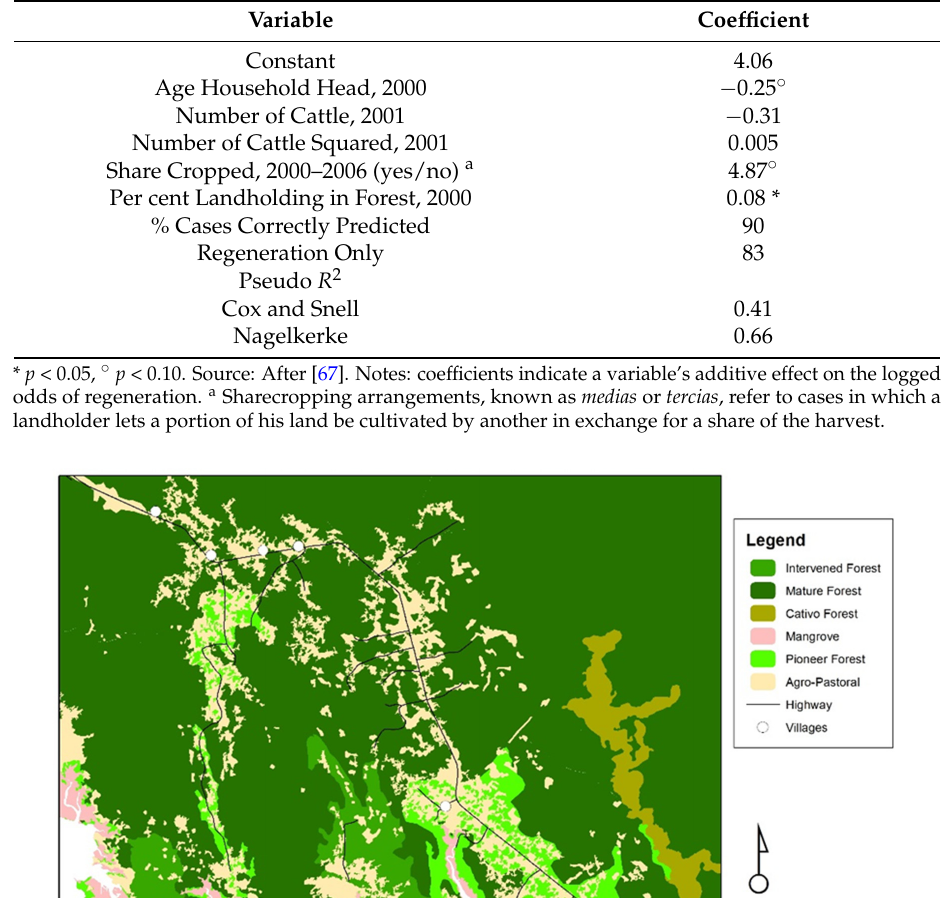
Table 3. Logistic regression of Mestizo household forest regeneration, Bayano-Darién frontier, 2000–2006.